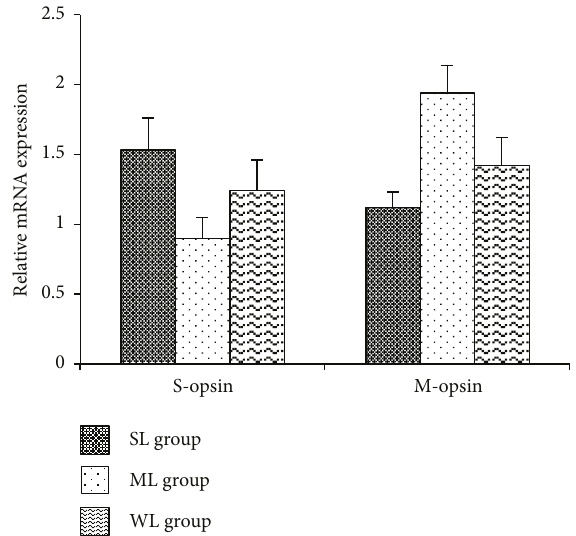
Figure 4: S- and M-opsin mRNA expressions in the retinas of guinea pigs irradiated by short-wavelength light, middle-wavelength light, or white light (represented as a bar graph). Expressions of S- opsins in the retinas of guinea pigs in the SL group were signi fi cantly higher than those in the ML group ( p < 0 05 ) while expressions of M-opsins in the retinas of guinea pigs in the SL group were signi fi cantly lower than those in the ML group ( p < 0 05 ). SL: short-wavelength light; ML: middle-wavelength light; WL: white light. ∗ means signi fi cant di ff erences between the SL and WL groups. # means signi fi cant di ff erences between the ML and WL